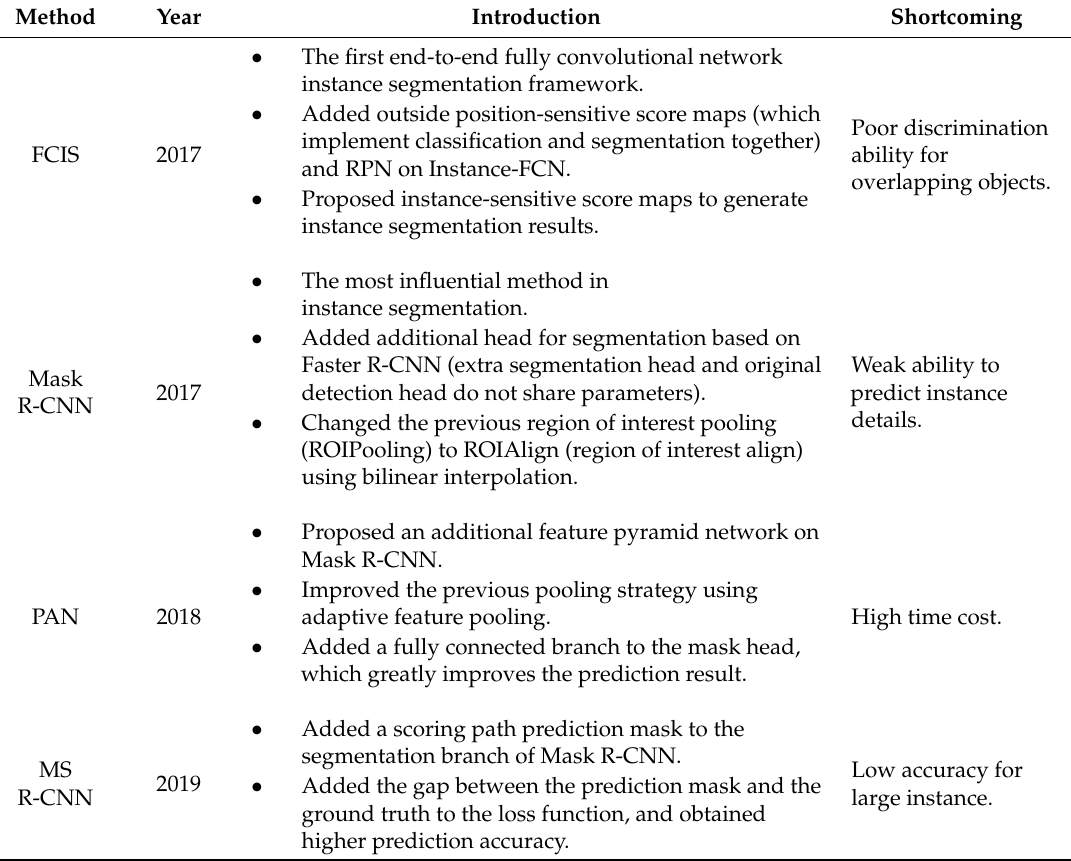
Table 1. Detailed introduction on the state-of-the-art instance segmentation methods, including